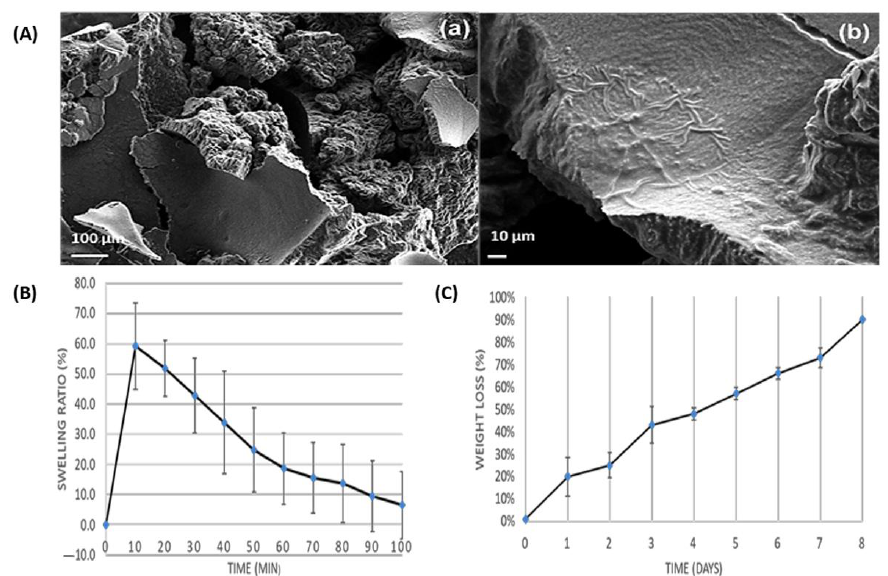
Figure 4. ( A ) FESEM micrographs of thermoresponsive gel containing HLRE and PPE (F15) at 100 kX ( a ) and 200 kX ( b ). ( B ) Swelling ratio and ( C ) biodegradation of thermoresponsive gels containing HLRE and PPE (F15), n = 3.